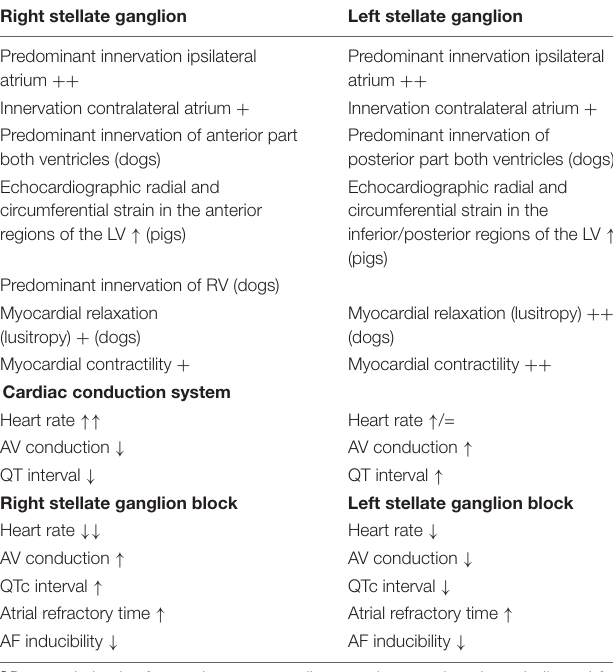
TABLE 1 | Summary of functional characteristics of the right and left sided ganglion stellatum. a Right stellate